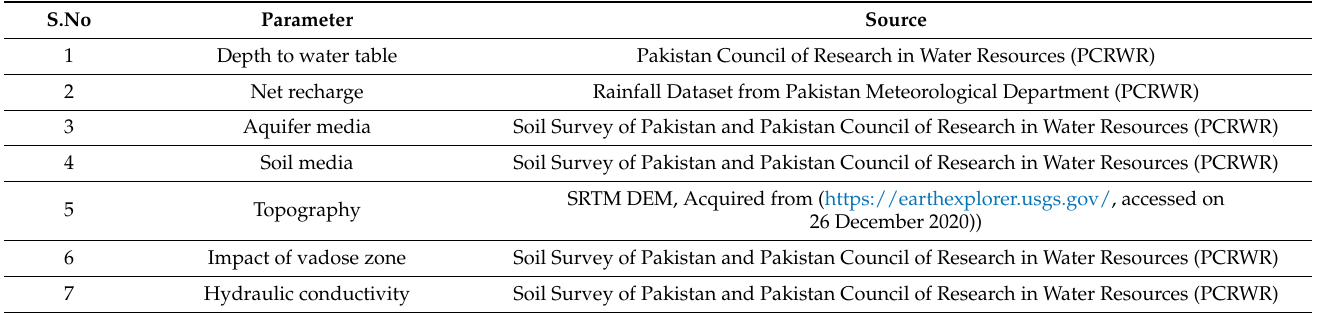
Table 1. All of the parameters’ data sources are listed in this